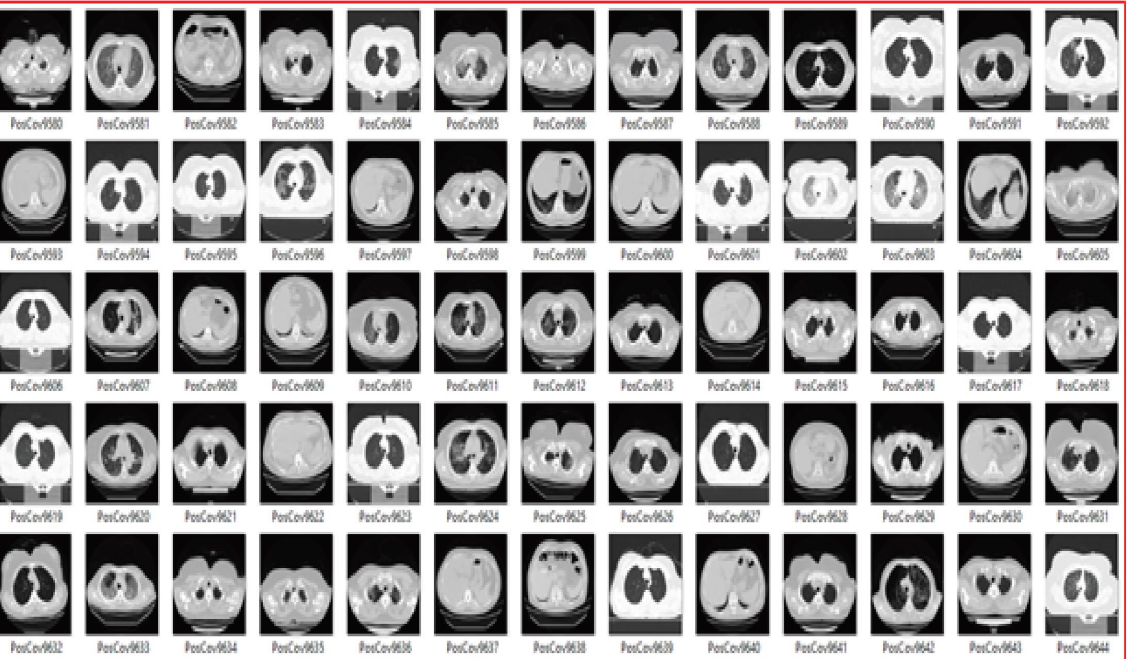
Figure 3: Input image dataset of Omicron